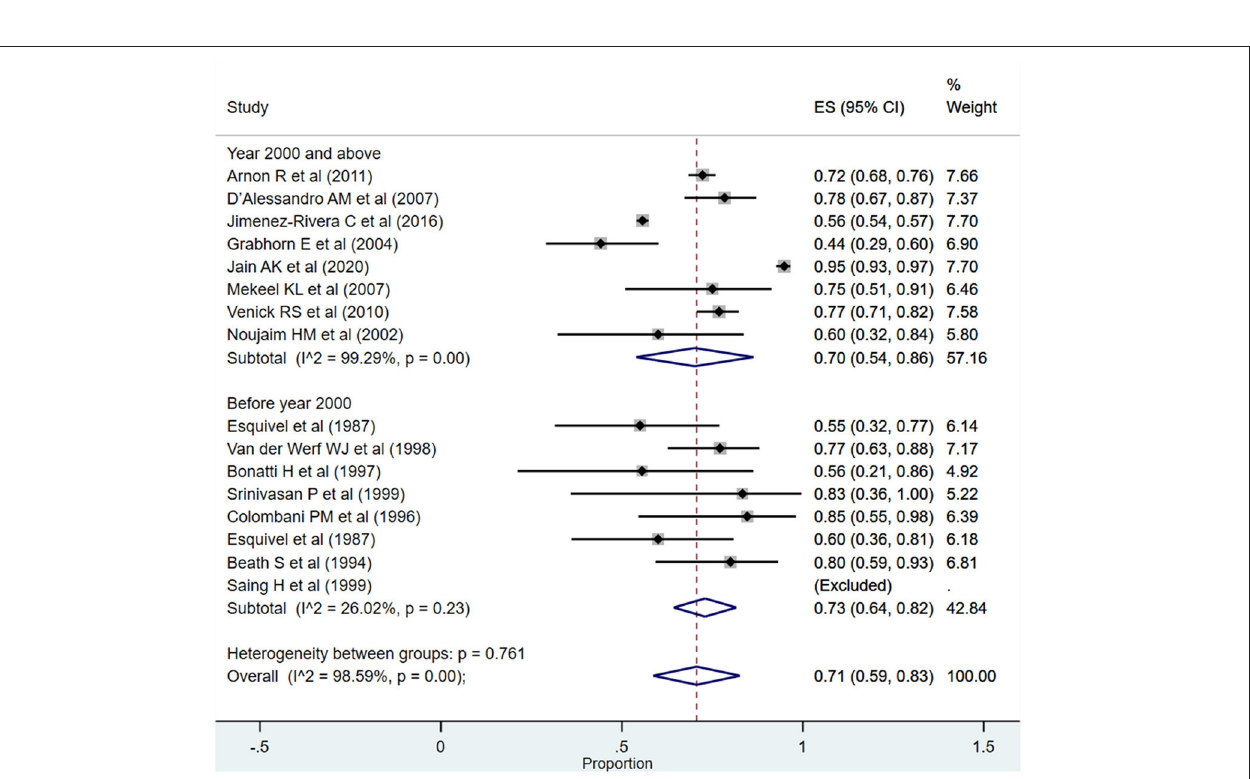
FIGURE 3 | Pooled patient survival rate among infants between > 1 and 5 years post-liver transplantation.